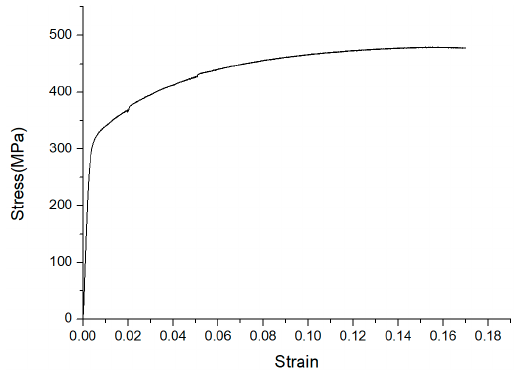
Figure 1. True stress-strain curve for TA2.